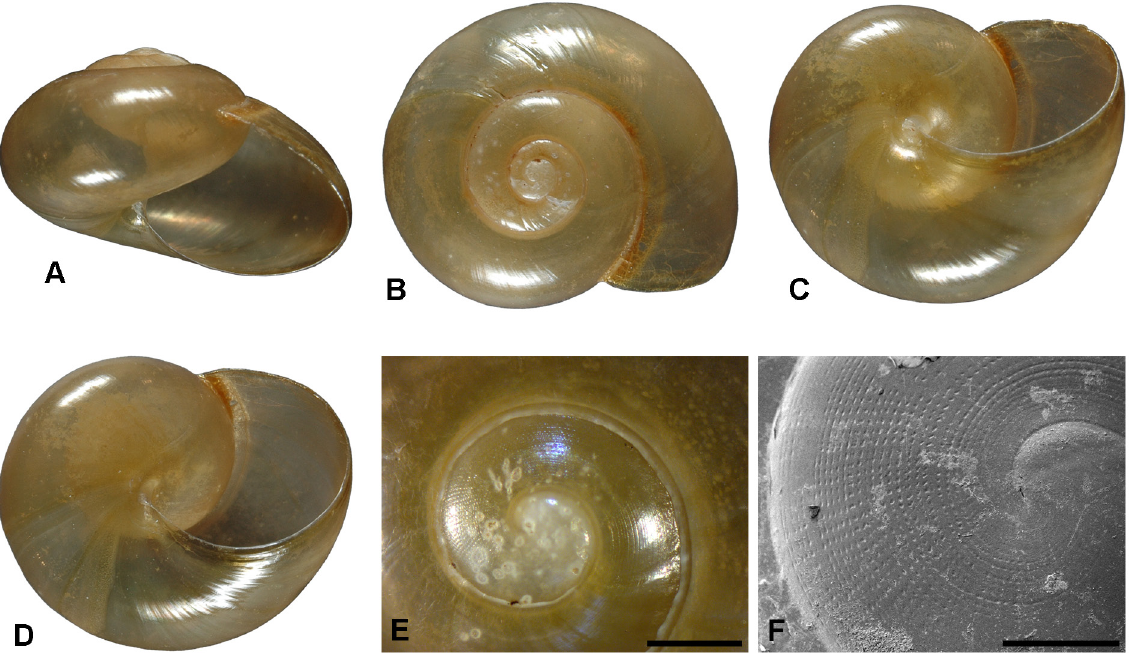
Fig. 4. Ptilototheca soutpansbergensis gen. et sp. nov. A–D . Holotype, diameter 9.2 mm (NMSA V5567/ T4069). E . Protoconch showing sculpture of punctate spiral lines, Entabeni Forest (paratype, NMSA P0186/T4063). F . SEM of protoconch microsculpture, Thathe Vondo Forest (paratype, NMSA W2080/ T4064). Scale bars: E = 0.5 mm; F =